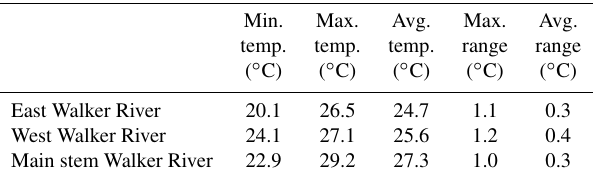
Table 3. Stream temperatures and temperature range within 300m modeled reaches by river from July 2012 TIR